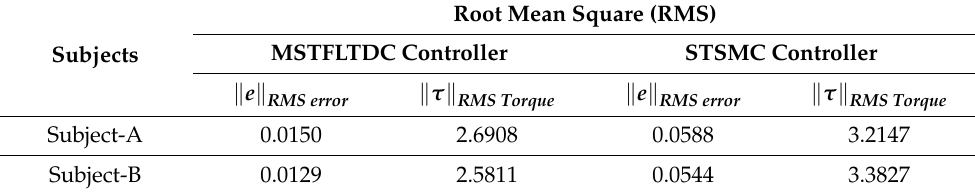
Table 2. Controller